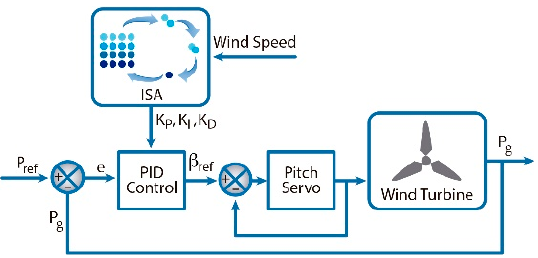
Figure 21. In control systems, ISO algorithms are used to search the best values to perform a control strategy, in this case to search the best gains values for a PID controller. Table 4. Summary with Intelligent Search Algorithms (ISA) for MPPT for wind energy. Reference Analysis of Analysis of Results